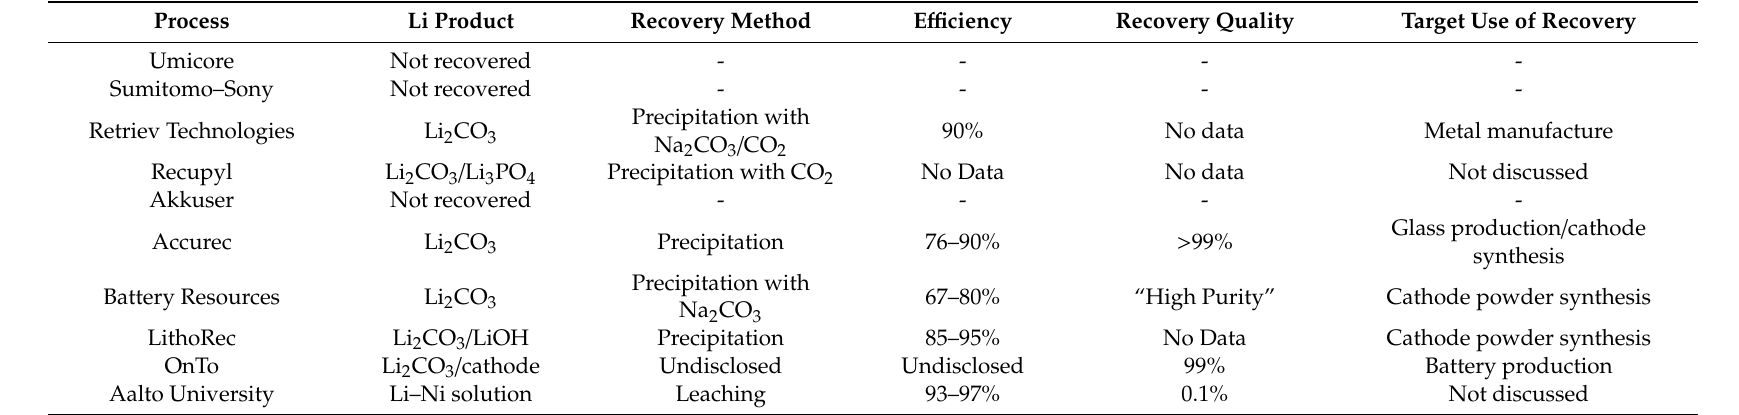
Table 4. Lithium recovery summary of the recycling